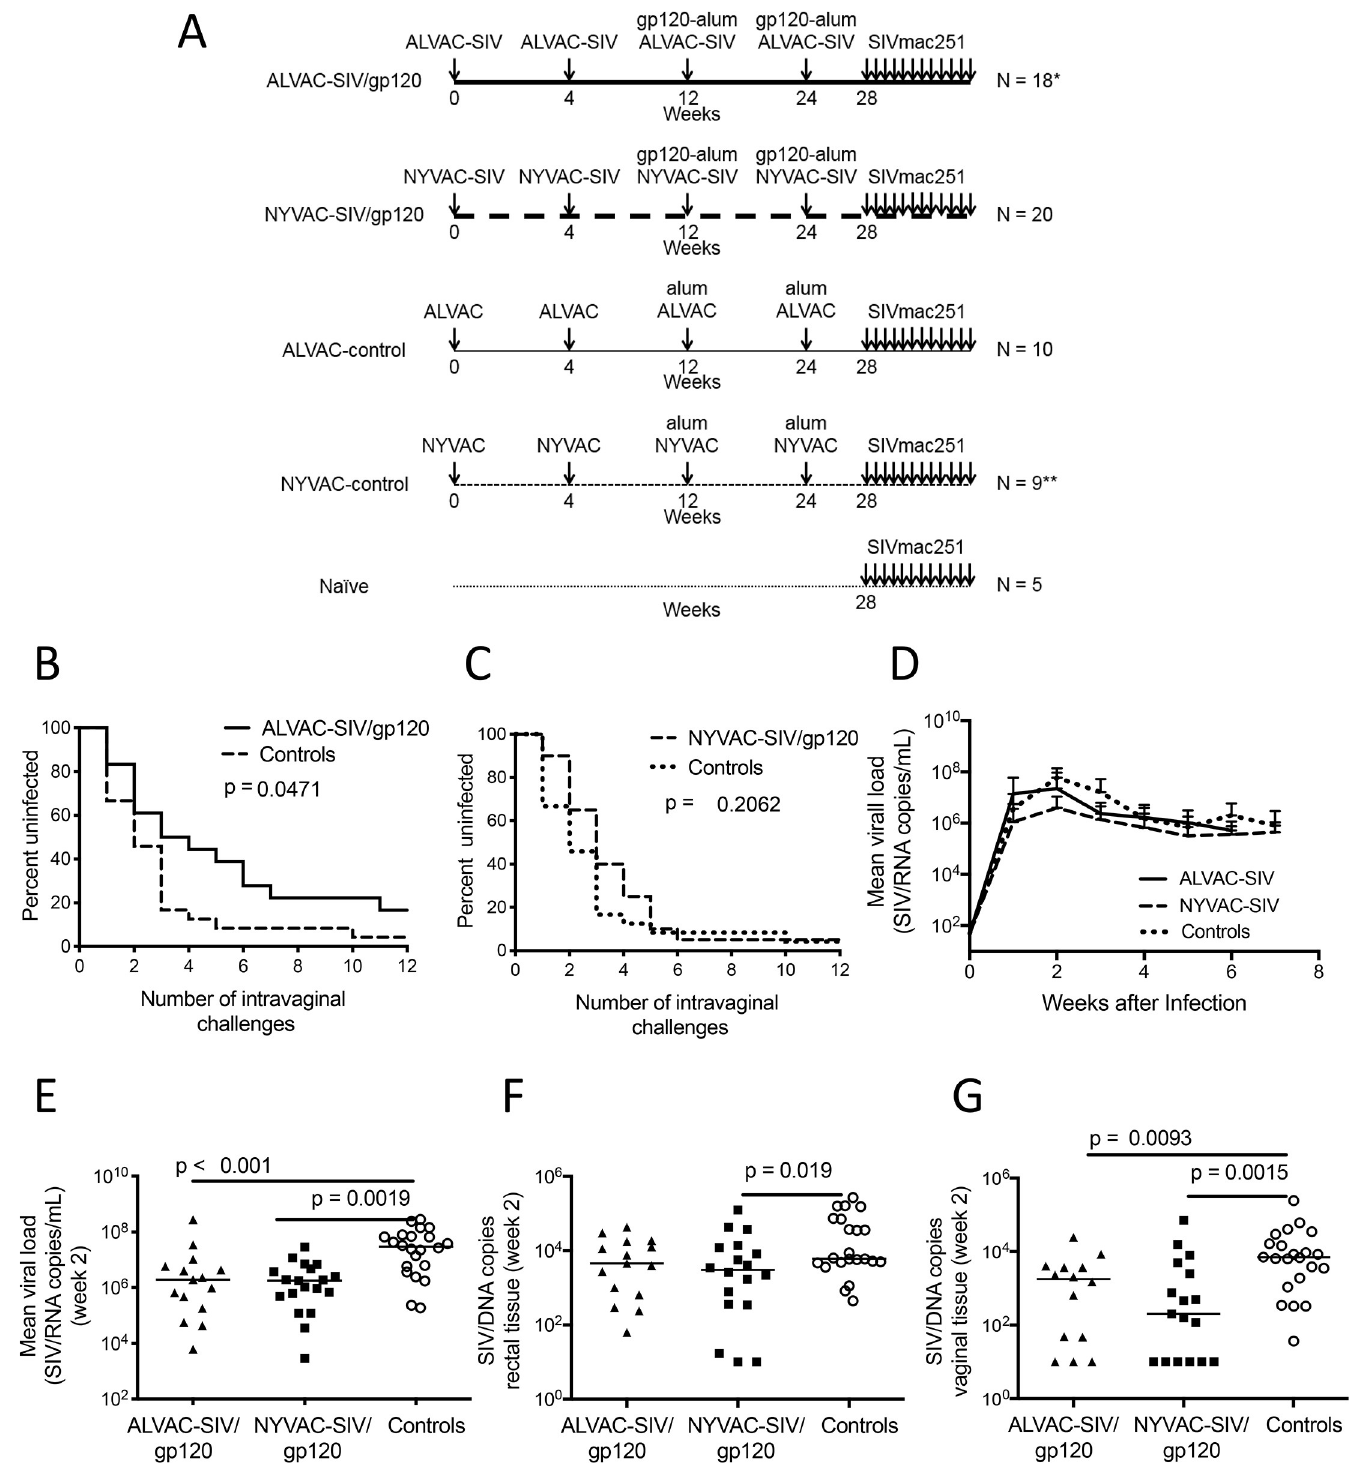
Fig 1. Study design and vaccine efficacy. (A) Study design. Animals were immunized with either ALVAC-SIV (vCP180; 20 animals) or NYVAC-SIV (VP1071; 20 animals) expressing Gag-Pol-Env of the SIV K6W clone of SIV mac251 [20] and boosted with the native form of SIV mac251 /gp120 adjuvanted in 5 mg of alum Alhydrogel. Two of the 20 animals included in the ALVAC-SIV group and one of the 10 animals in the NYVAC-parental group died before the challenge phase for reasons unrelated to the vaccine. (B, C) Acquisition curves following SIV mac251 intravaginal administration in the (B) ALVAC-SIV (n = 18) and (C) NYVAC-SIV immunized (n = 20) animals compared to the pooled control groups ( S1A Fig ). (D) Logarithmic mean ± s.d. of SIV/RNA levels in the plasma of the animals that became infected in